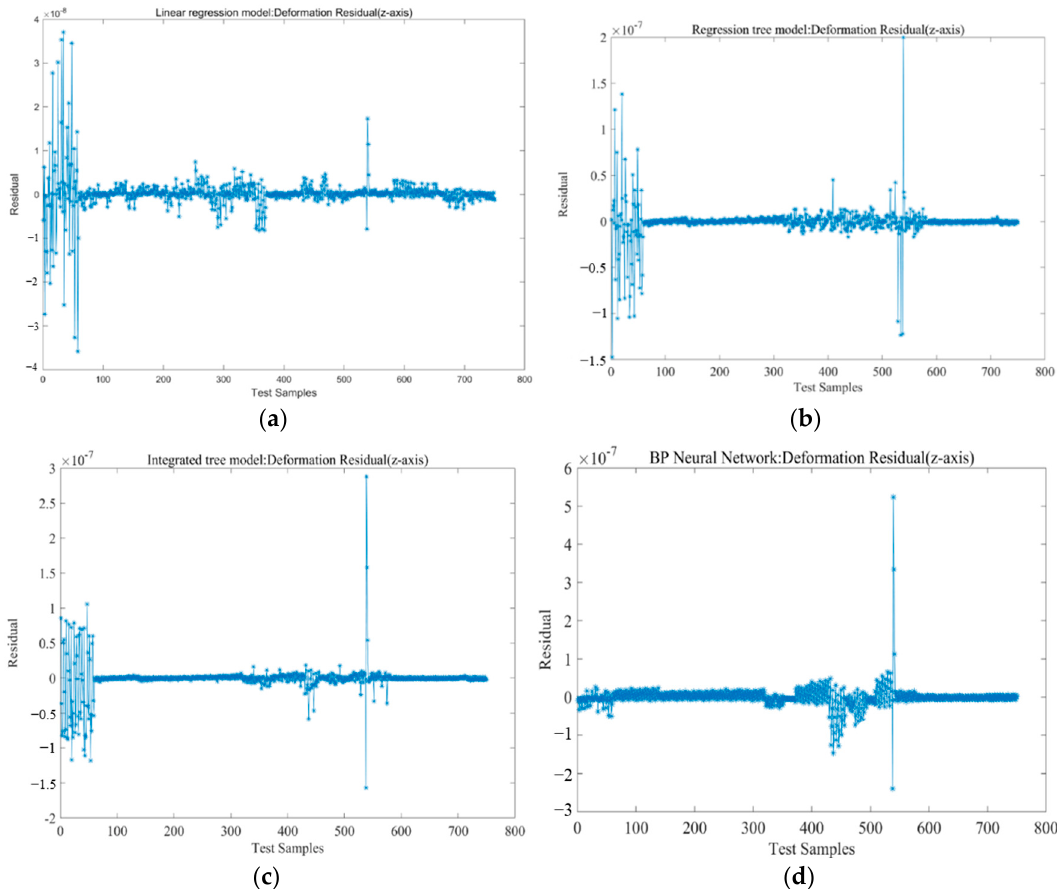
Figure 4. Output response of each training model: ( a ) Linear regression model; ( b ) Regression tree model; ( c ) Integration Tree Model; ( d ) BP neural network model.